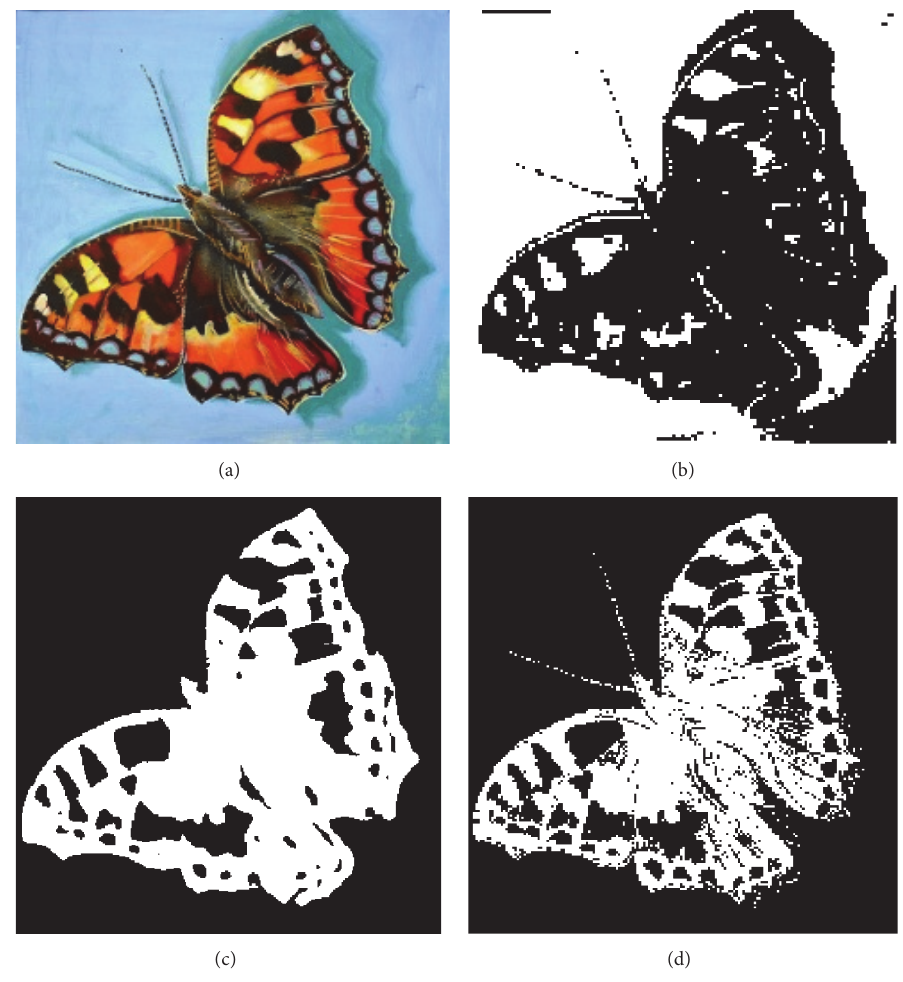
Figure 2: (a) Primary image. (b) CV segmentation. (c) BFV segmentation. (d) TLBO-BFV